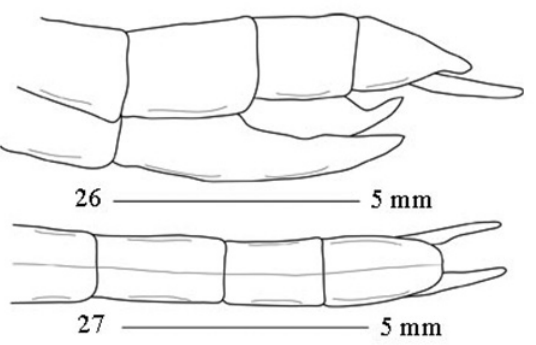
Figs 26–27. Parasinophasma sparsigranulatum sp. n. 26. ♀ , apex of abdomen, lateral view; 27. ♀ , apex of abdomen, dorsal